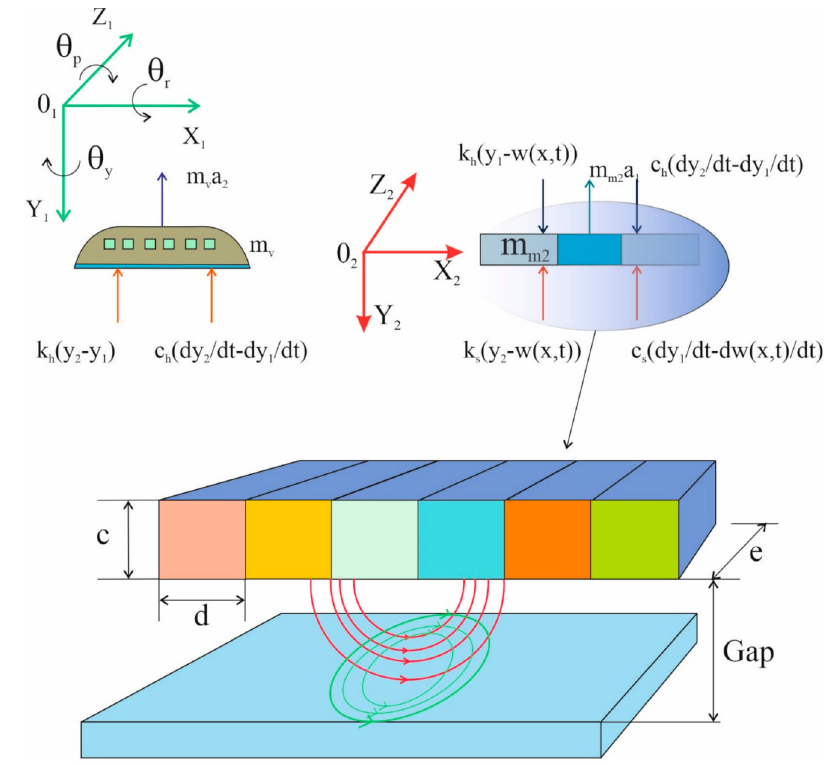
Figure 4. Coordinate system for the body and levitation